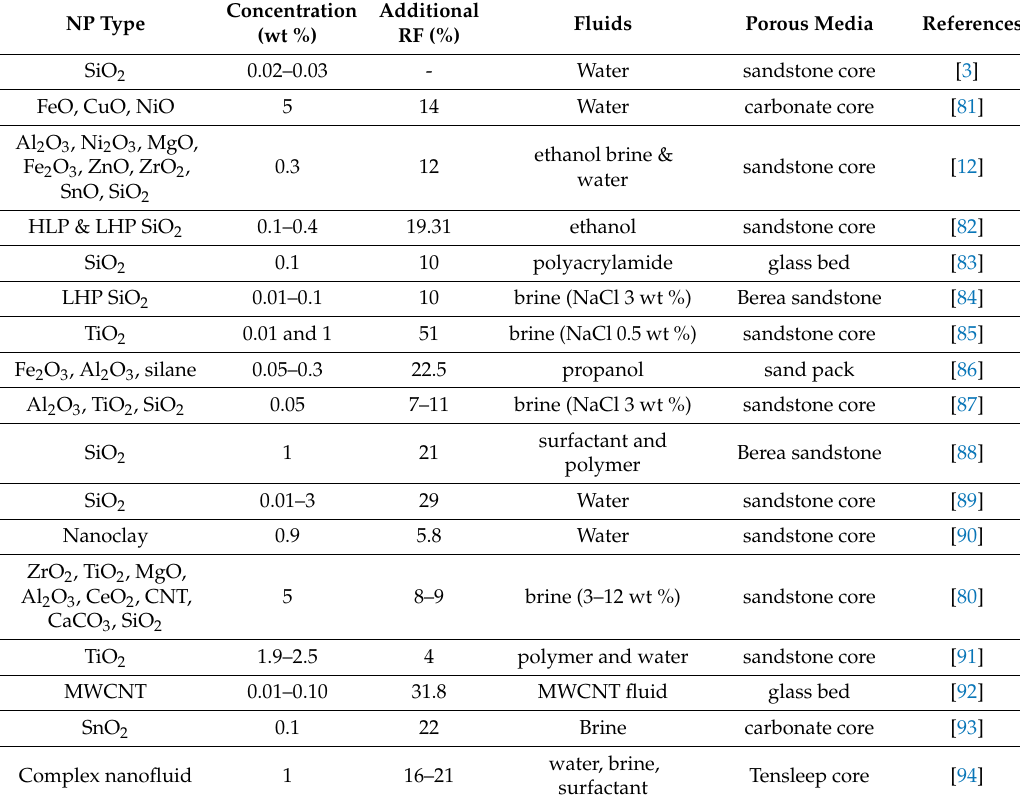
Table 2. Summary of the reported experimental studies on nanofluiding